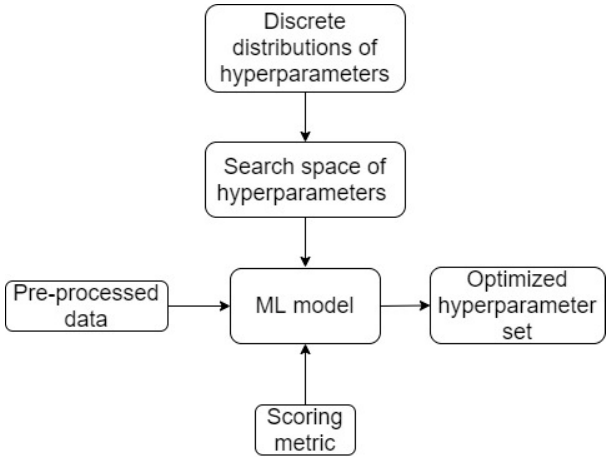
Figure 8. Schematic of workflow 1.